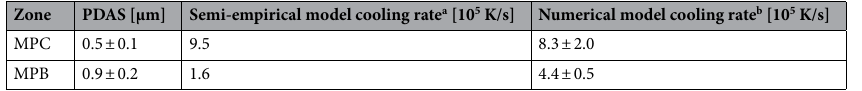
Table 4. Cell size quantification of the MPC and MPB, and the estimation of local cooling rates based on a semi-empirical equation and numerical model. a Cooling rate prediction based on the analytical equation Eq. (1). b Cooling rate prediction based on the numerical heat transfer